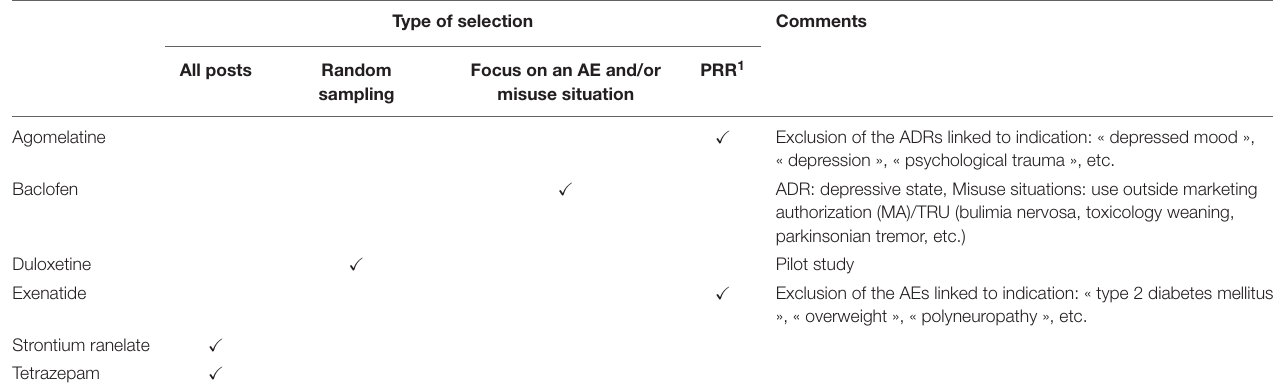
TABLE 1 | Various approaches used for post selection before